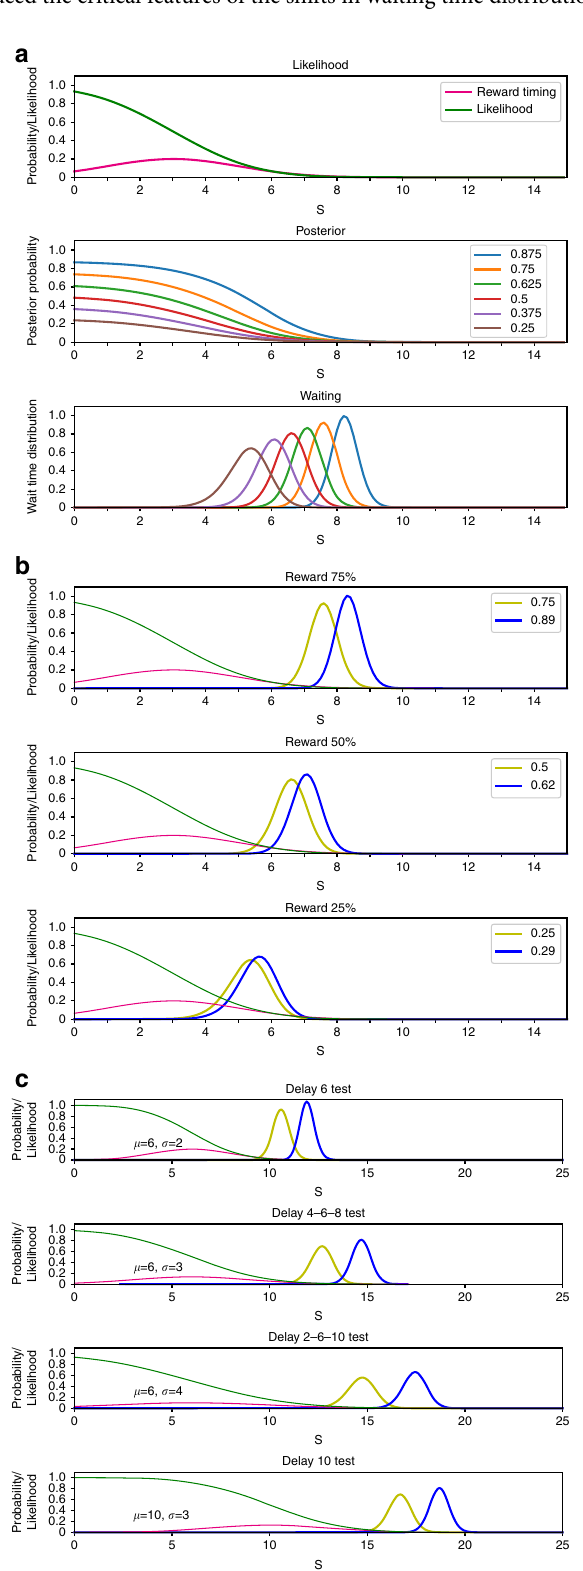
effects of reward probability and timing uncertainty on promotion of patience by serotonin. a Top panel: the model assumes that the subject has a probabilistic model of reward delivery timing (magenta line), which is assumed to be Gaussian with μ = 3 s and σ = 2s in this example. As the time passes without reward delivery, the likelihood of a reward trial diminishes according to the cumulative density function (green line). Middle panel: the posterior probability for a reward trial goes down along with the likelihood, but persists longer if the prior probability for a reward trial is higher. Bottom panel: the timing of quitting is shifted later with a higher prior probability (Methods). b We assume that dorsal raphe serotonin neuron stimulation causes an overestimation of the prior probability when the reward probability is higher ( p ′ = p + p 2 − p 3 in this example). The yellow and blue lines show the time of quitting without and with increased prior probability, respectively. The effect of serotonin neuron stimulation is largest with a reward probability p = 0.75 (top panel; μ = 3 s and σ = 2s). c With a larger uncertainty σ of reward timing, the waiting time distribution shifts later and the effect of serotonin neuron stimulation (increase of prior probability from 0.75 to 0.95 in this example) increases. A shift in the average reward timing (bottom panel; μ = 10s and σ = 3 s) does not cause a large increase in waiting time with serotonin neuron